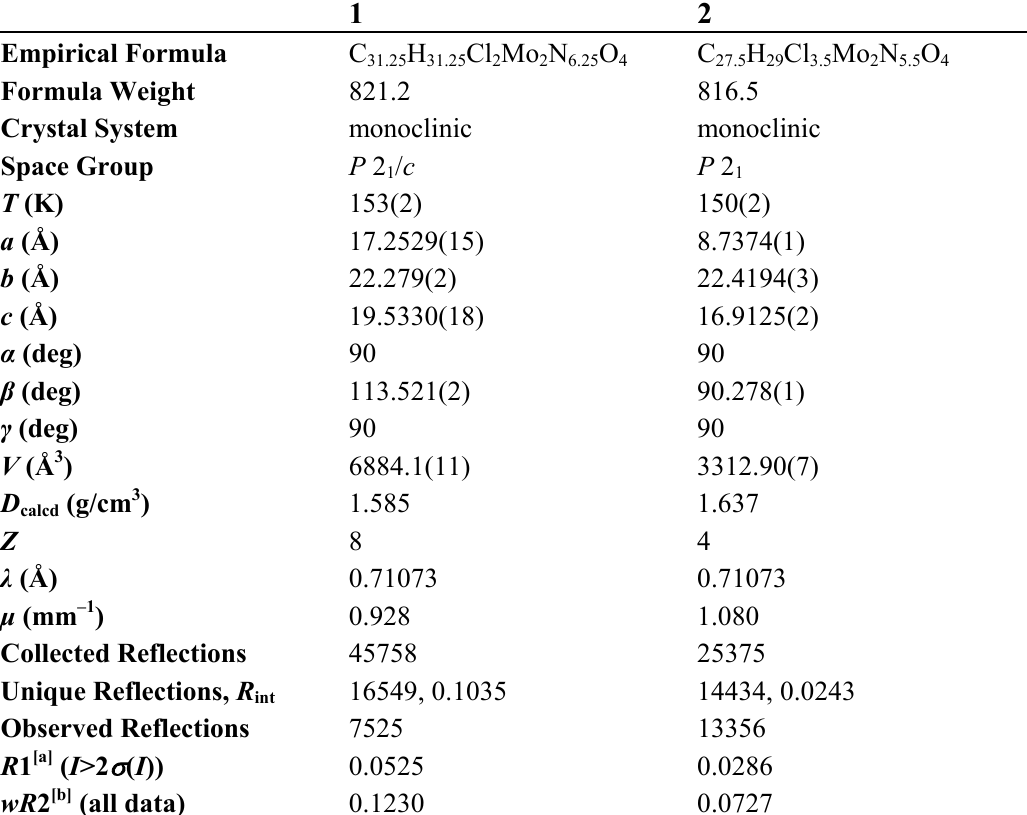
Table 2. Crystallographic data for 1 and 2